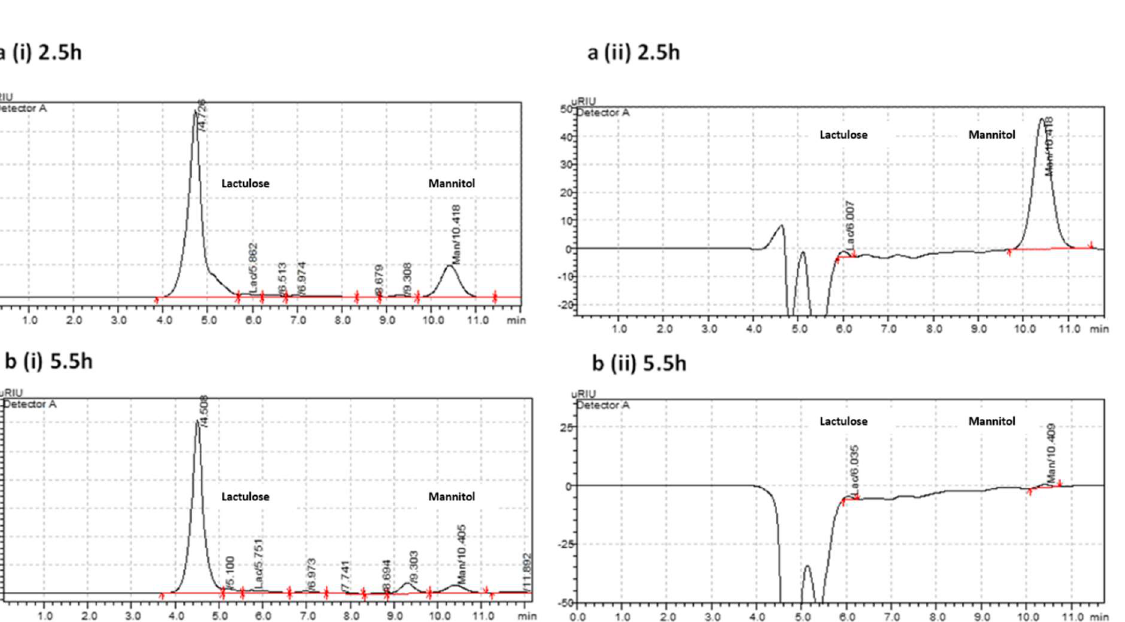
Figure 4. Detection of lactulose and mannitol over a 6 h testing period. Lactulose and mannitol were well-resolved in urine samples at 5.9 and 10.4 min, respectively. Chromatograms depict peaks of each sugar in urine samples before ( a ( i ), b ( i )) and after ( a ( ii ), b ( ii )) correction of the respective sample with the baseline ‘blank’ urine sample at 2.5 h and 5.5 h post-ingestion of the lactulose mannitol test solution.